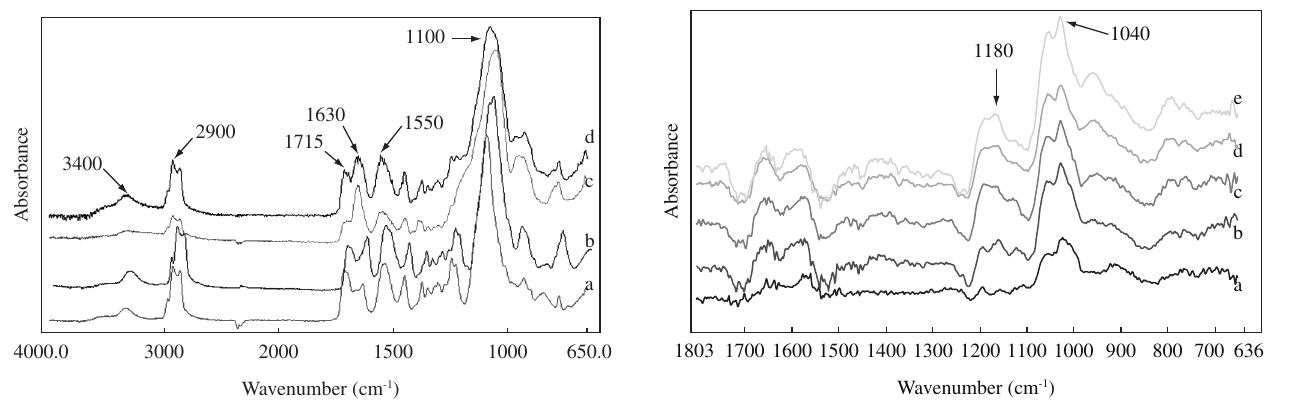
Figure 4. FTIR spectra of a) pure polyurethane PU-1 and polyurethanes hav- ing inorganic moieties: b) C1-A; c) C1-D; and d) C1-E.